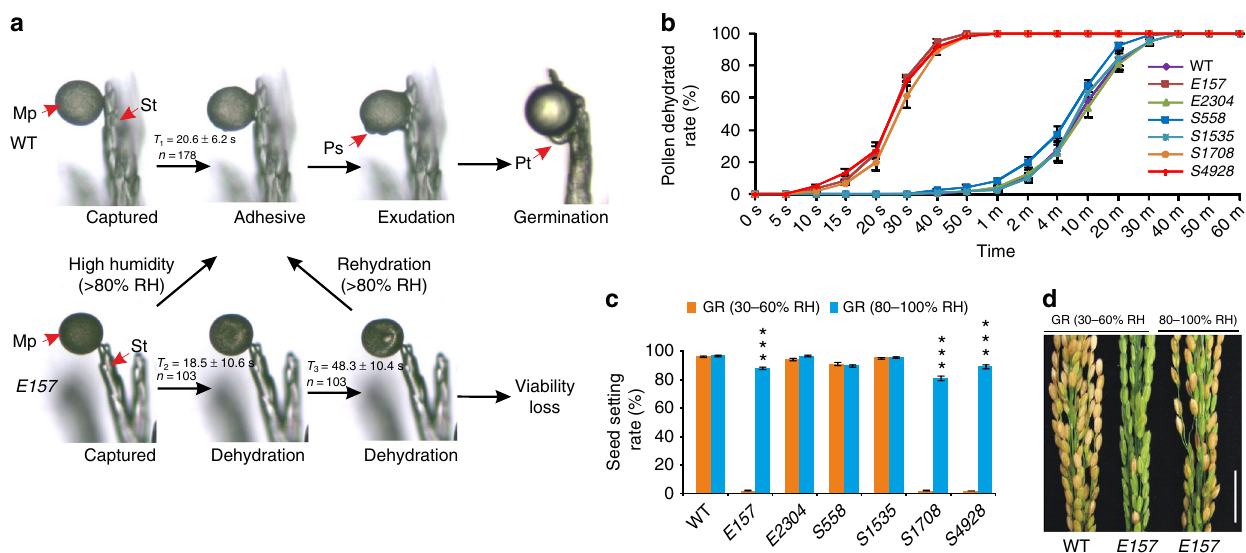
Fig. 3 Characterization of humidity-sensitive genic male sterility. a Germination of WT and mutant pollen on the stigma. T 2 and T 3 refer to the period between, respectively, the time when the pollen came into contact with the stigma and the onset of pollen dehydration, and from the onset of dehydration and complete dehydration. Mp mature pollen, Ps protrusion, Pt pollen tube, St stigma. b Pollen dehydration at 27 – 32 °C, 30 – 60% RH. The ratio between the numbers of dehydrated and total pollen grains is presented in the form of mean ± s.d., n = 3. c Seed set of the WT and mutant plants in different humidity. The data are presented as means ± s.d., n = 15. *** P < 0.001, Student ’ s t tests. GR growth room. d Spikelets of the WT and mutant E157 plant grown in different humidity. Scale bar, 2 cm